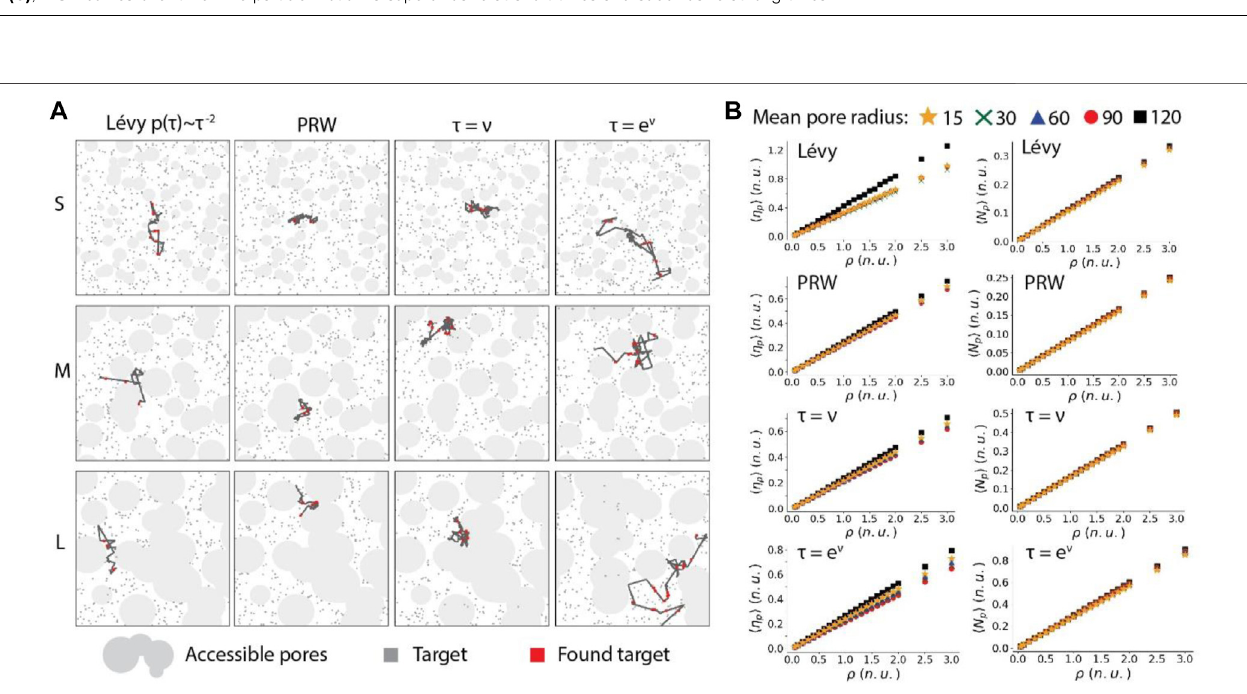
FIGURE 10 | The search ef fi ciency of a particle in fl uenced by the moving strategies in the convex porous environments. (A) , Examples of a particle moving according to the Lévy walk, PRW, linear RWSP and nonlinear RWSP in the porous media and searching for targets. S represents small pore size ( r p (cid:2) 30pixels, σ (cid:2) 5pixels), M represents intermediate pore size ( r (cid:2) 60pixels . , σ (cid:2) 10pixels), and L represents large pore size ( r (cid:2) 90pixels, σ (cid:2) 15pixels). Light gray areas are p p p p p accessible to the particle and white areas are inaccessible. Gray dots are the targets, and red dots are the targets found by the particle. Dark gray lines are particle trajectories. (B) , The search ability and ef fi ciency over the target density ρ in fl uenced by the pore sizes.